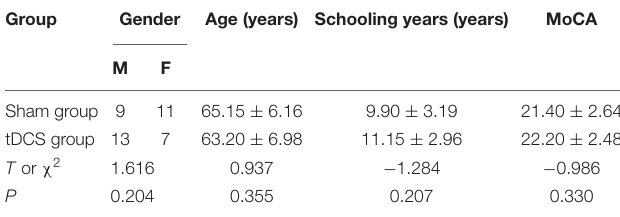
TABLE 1 | Comparison of demographic information and basic clinical data between the two groups.